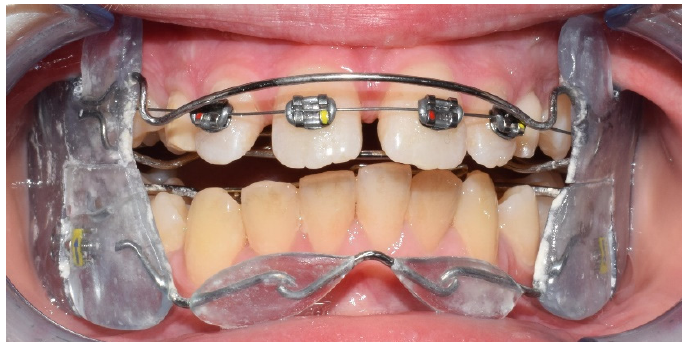
Figure 1. Fränkel II appliance and 2 × 4 fixed appliance.